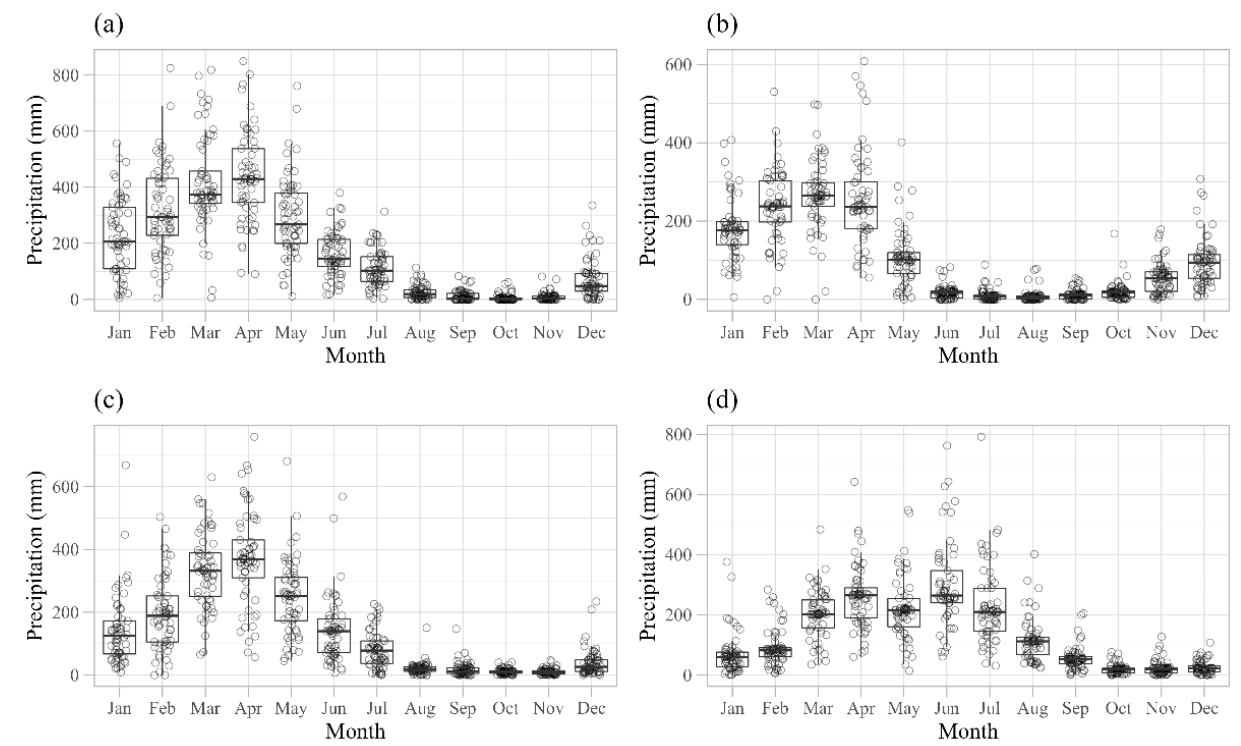
Figure 7. Monthly rainfall boxplot (mm) in NNEB — São Luís ( a ), Teresina ( b ), Fortaleza ( c ), and Natal ( d ) in the period from 1960 to 2020.